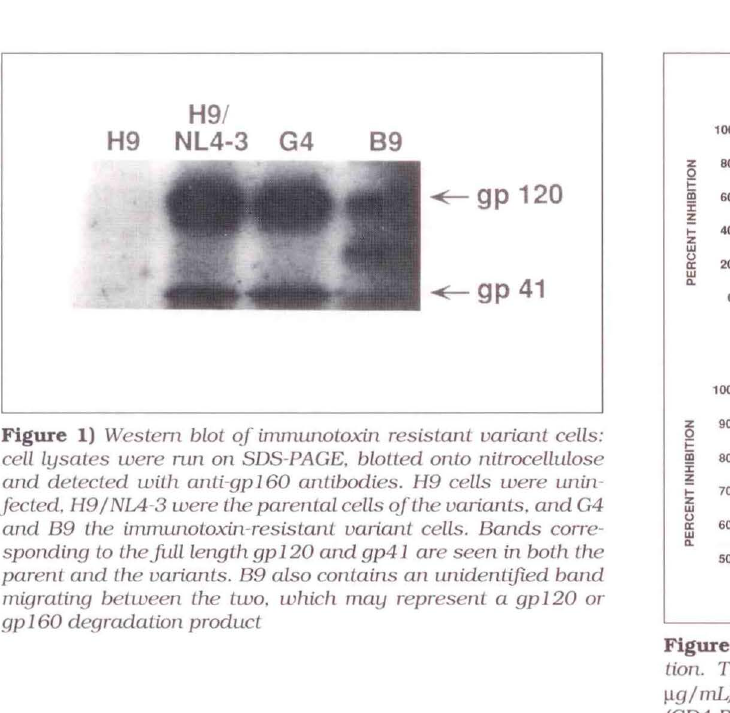
Figure 2) Effects of lysosomal inhibitors on immunotoxinfunc tion. The cytotoxic effect of suboptimal concentrations